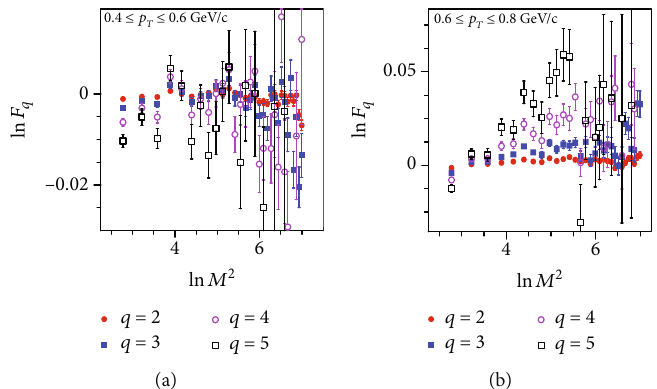
M 2 ) for EPOS3-hydro+cascade events for the p